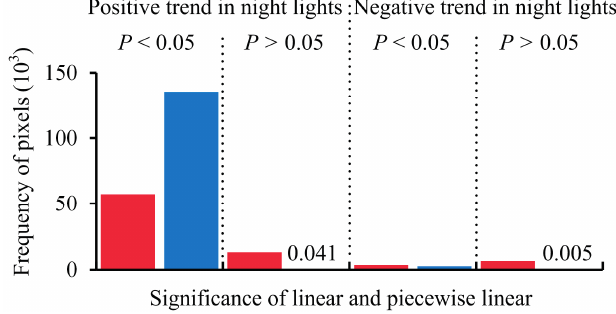
Figure 4. Statistical distributions of linear (red) and piecewise linear (blue) model for NTL data time series at pixel level. The significance of trend is tested under 95% confidence